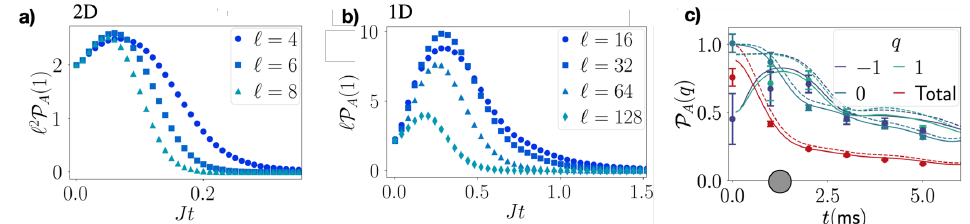
Figure 2: Evolution of symmetry-resolved entropies in NISQ devices. Panel a,b) : time evolution of the symmetry-resolved purity normalized by the partition volume, correspondent to a quantum quench from a charge-density-wave state, with the dy- namics described in Fig.1a-b), respectively. At short times, decoherences induces a universal scaling behavior, that corresponds to a log-volume entropy scaling, and a purity scaling with inverse of the partition volume. Panel c) : symmetry-resolved pur- ity for a long-range XY spin chain of L = 10 sites, with (cid:96) = 4. The lines represent theoretical simulations, with (solid) and without (dashed) decoherence. Dynamical purification is only present in the first case. Circles represent experimentally recon- structed data from for the symmetry-resolved purity in the trapped ion experiment of Ref. [ 29 ] . Dynamical purification is experimentally observed for q = − 1, and evident for q = 1 (albeit with larger error bars) in agreement with both theory and